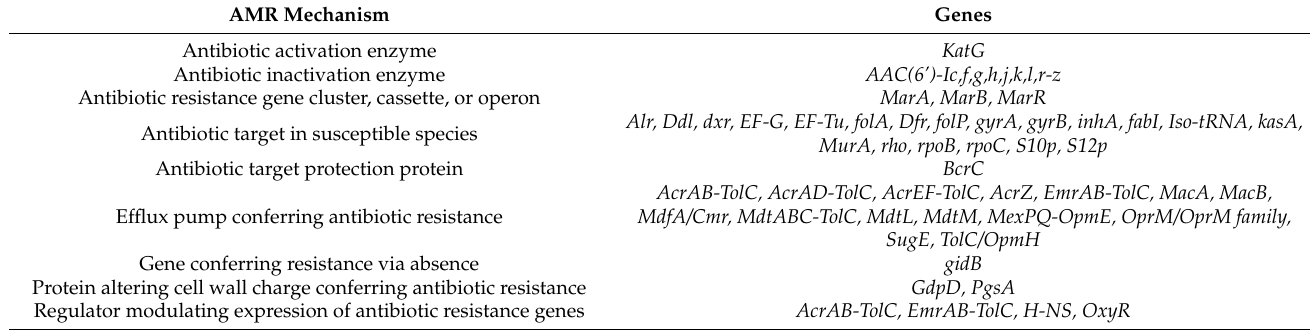
Table 3. The multi-drug resistance virulence profile of Salmonella enterica subsp. enterica Typhimurium 4:i:1,2_69M isolated from human